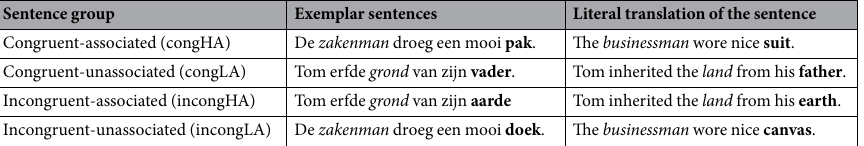
Table 1. Sentence groups, exemplar sentences and their literal translations into English. Prime words are in italic, whereas target words – in